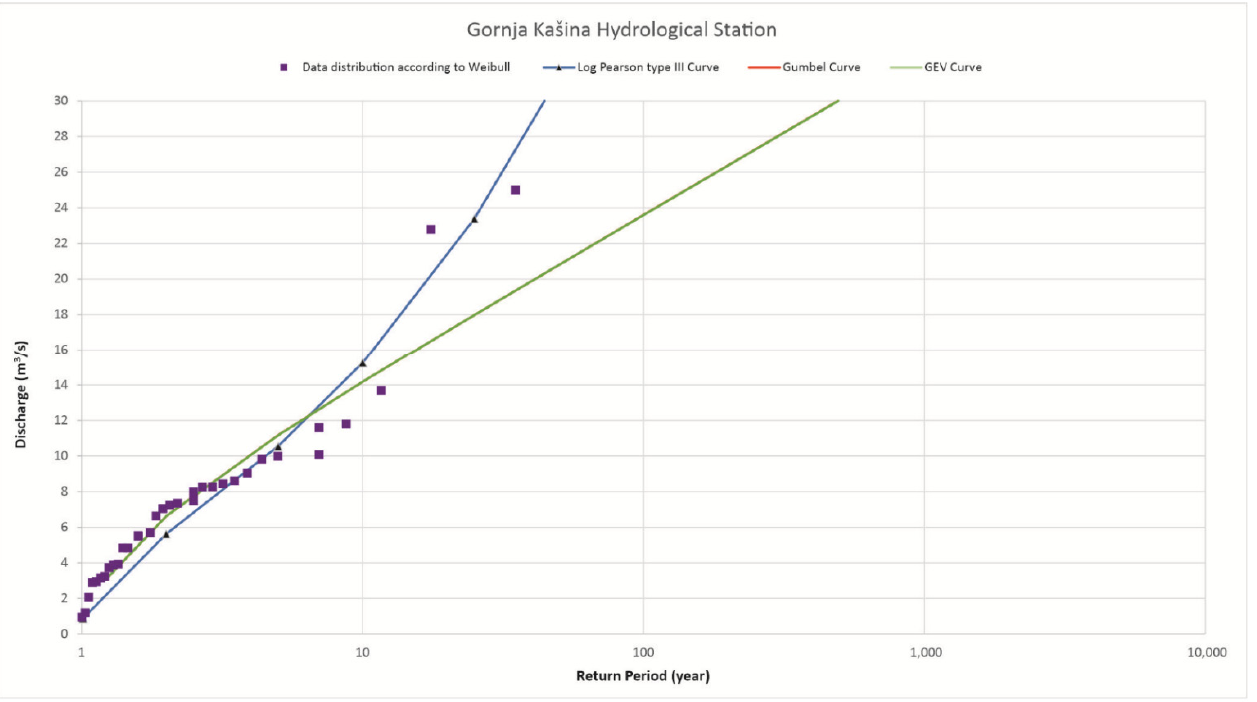
Figure 4. Frequencies of the maximal annual discharges on the “Gornja Kašina” hydrological station.